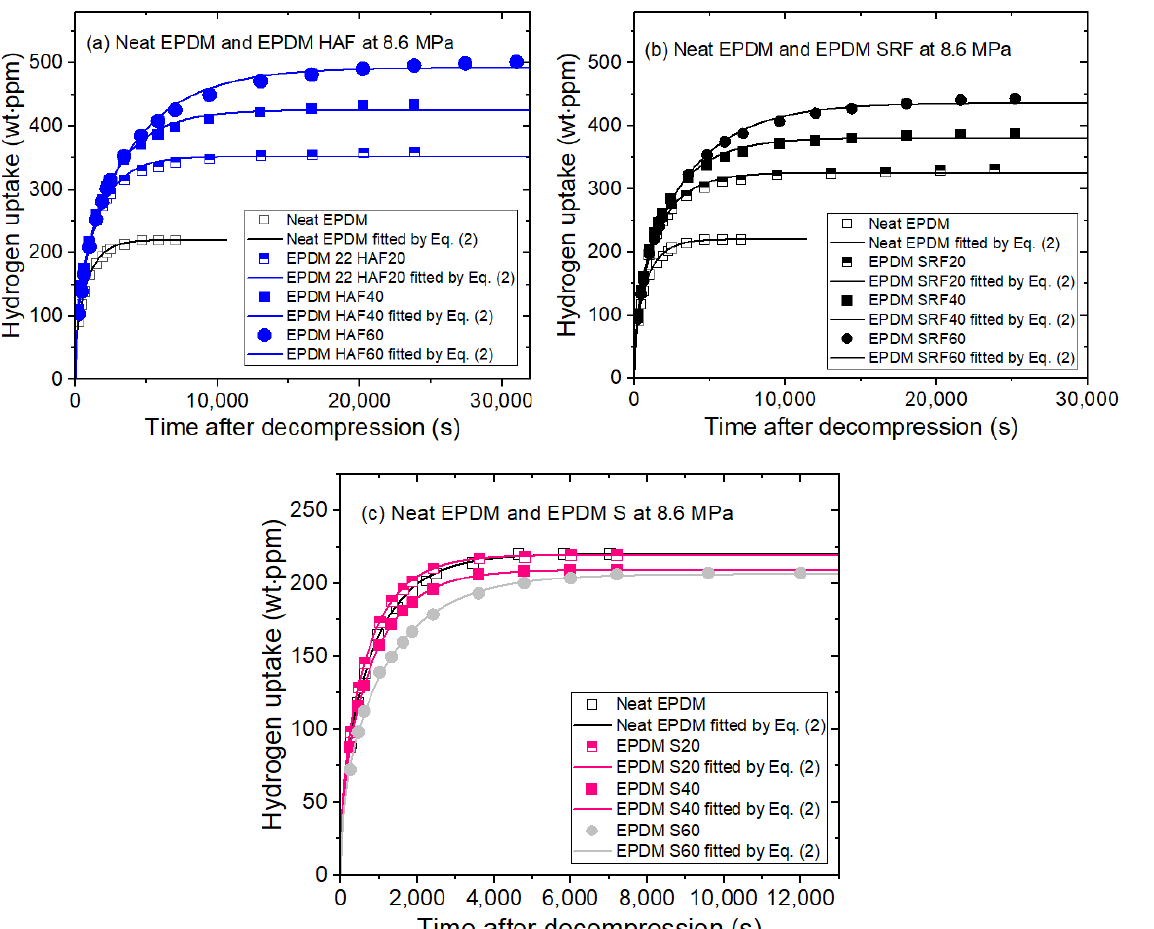
Figure 2. H 2 uptake by the ( a ) EPDM HAF series, ( b ) EPDM SRF series, and ( c ) EPDM S series after hydrogen exposure at 8.6 MPa. The solid lines are the least ‐ squares fits to Equation (2) using the diffusion analysis program. The results for neat EPDM are included in the three panels for comparison with those for the blended EPDM composites with fillers. The squared correlation coefficient (R 2 = 0.99) indicated good fits between the data and Equation (2).